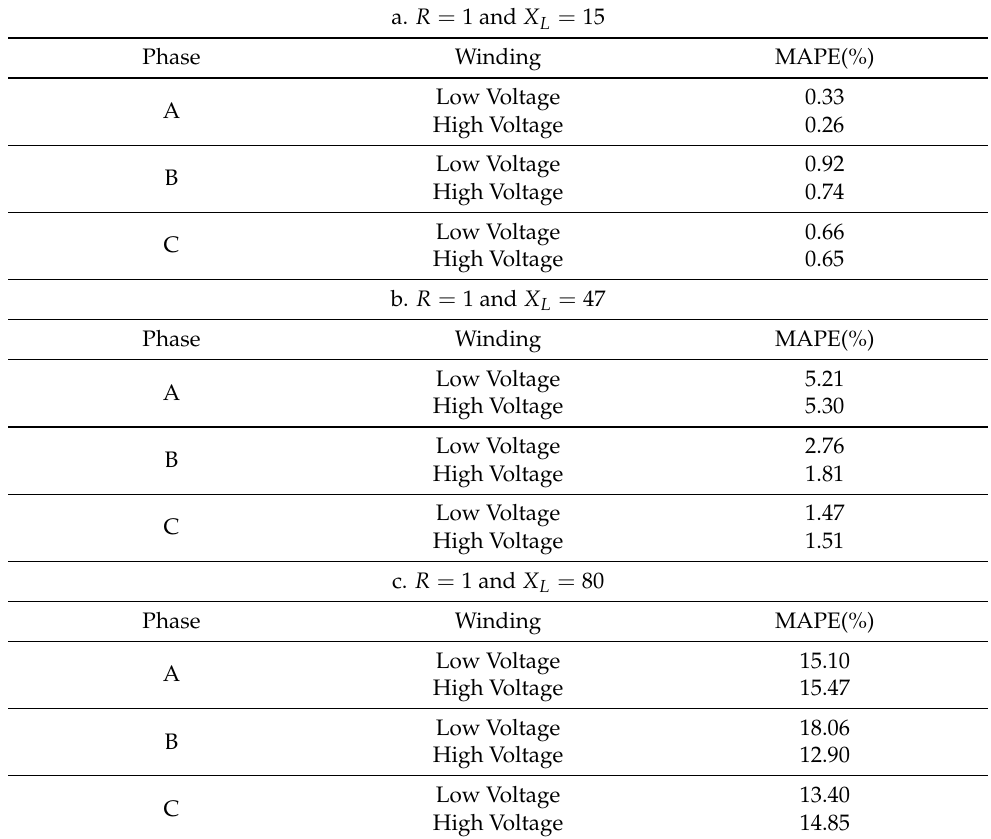
Table 9. Mean absolute percentage error for the ANN